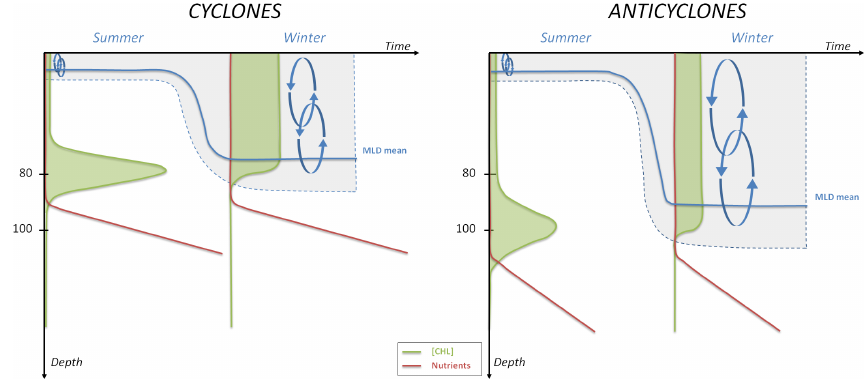
Figure 8. Conceptual view summarizing the basin-scale seasonal changes in the vertical distribution of chlorophyll (green), nutrients (red), mixed layer (shaded gray area), and mean mixed-layer depth (blue), in cyclones and anticyclones. The total chlorophyll content is represented by the green area, which is approximately the same in summer and winter for either cyclones or anticyclones. By contrast, the chlorophyll content in cyclones is larger than in anticyclones for either season, showing that cyclones have slightly higher biomass. This may be the result of slightly higher nutrient supply in cyclones due to a steeper nutricline, and hence a higher diffusive flux. Finally, note that the mixed layer does not on average reach the nutricline in winter, but it does reach the deep chlorophyll maximum, resulting in the vertical redistribution of chlorophyll via vertical mixing and/or photoacclimation